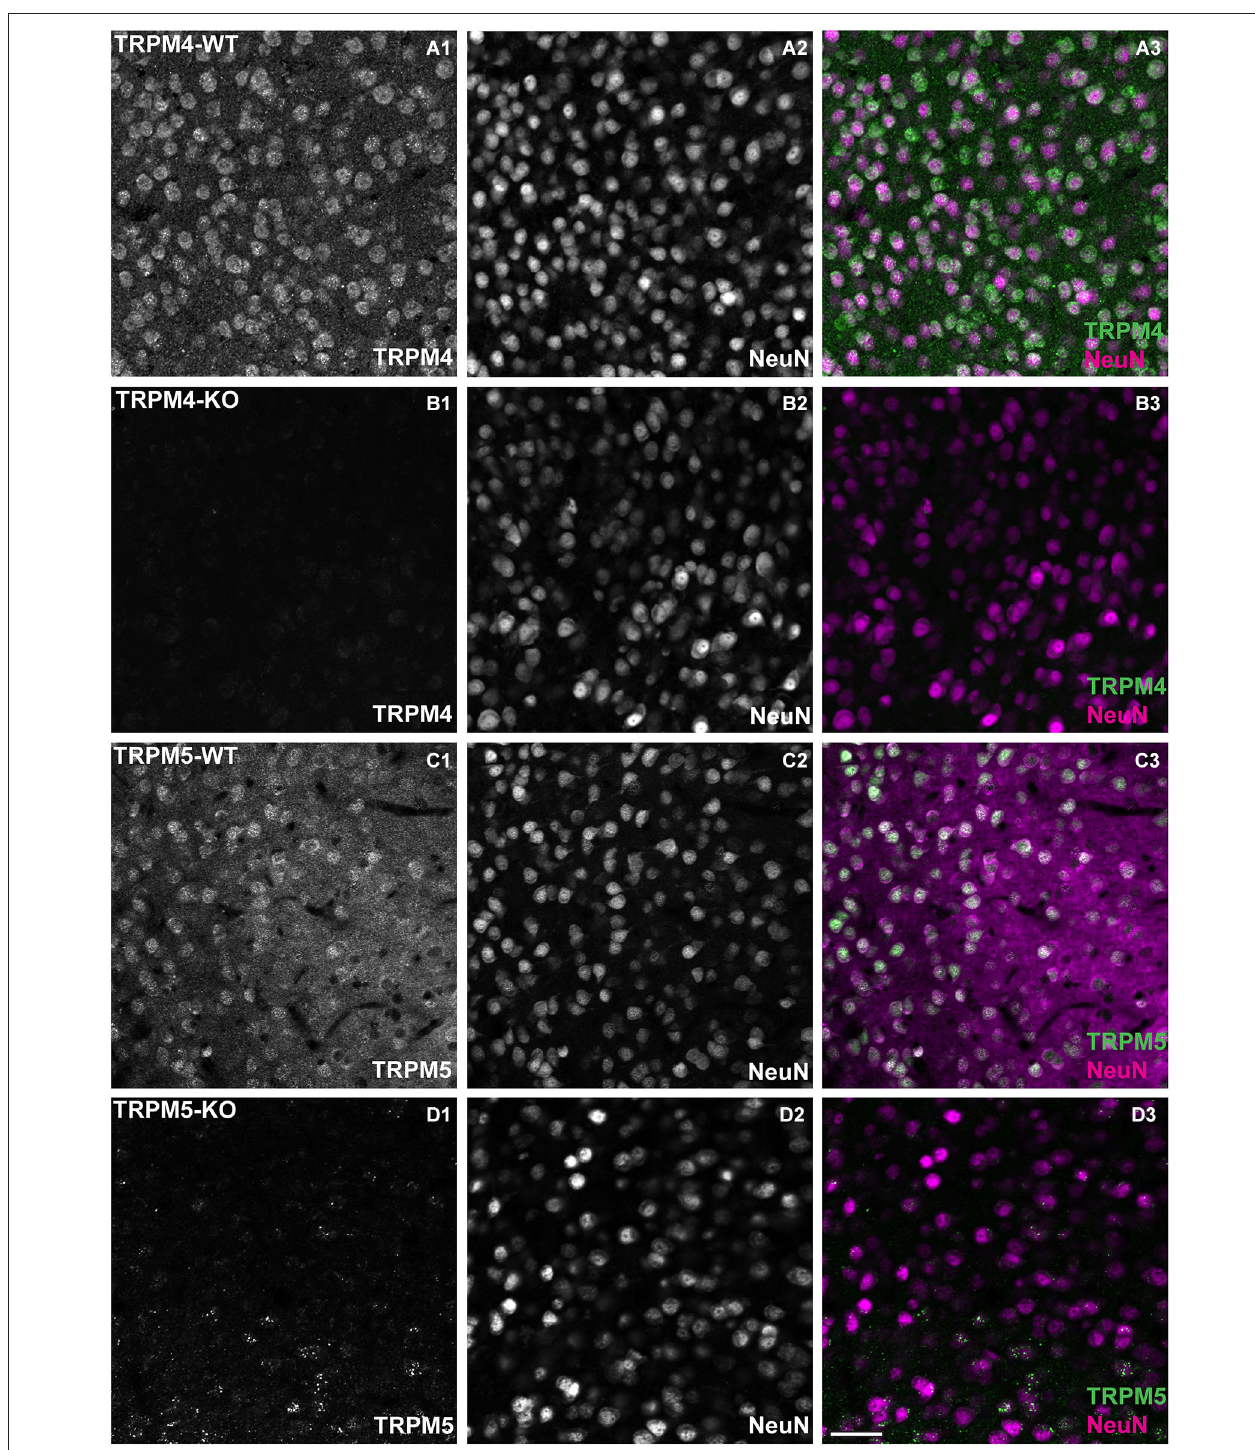
(TRPM4-KO) mice (B1–B3) . TRPM5 + / − heterozygous mice showed